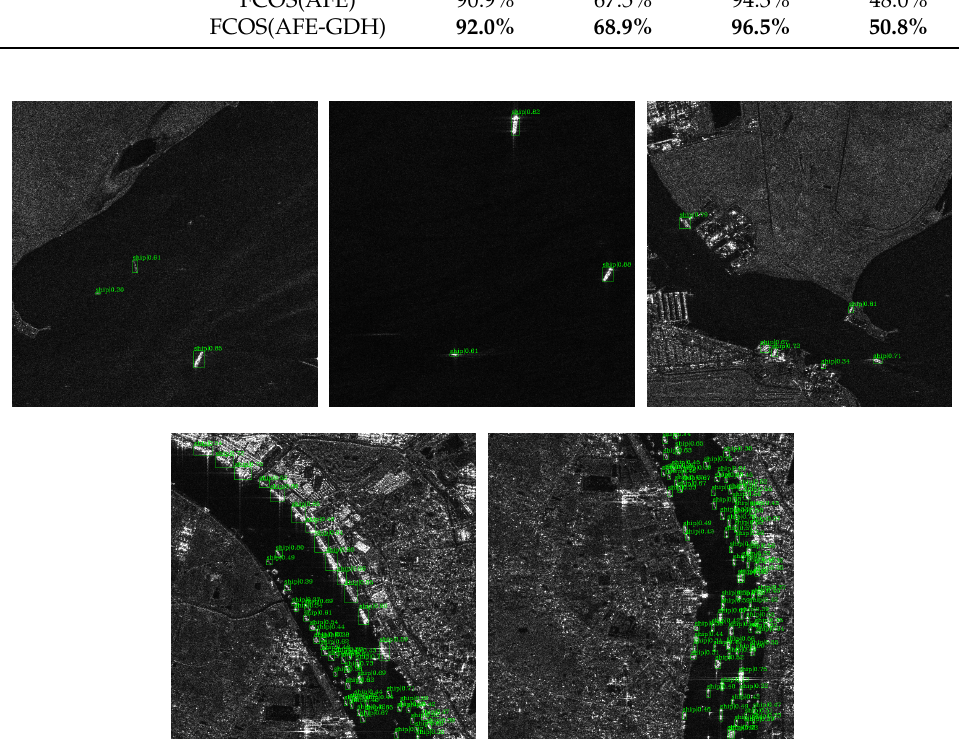
Figure 15. Some of the detection results obtained by the proposed overall framework on